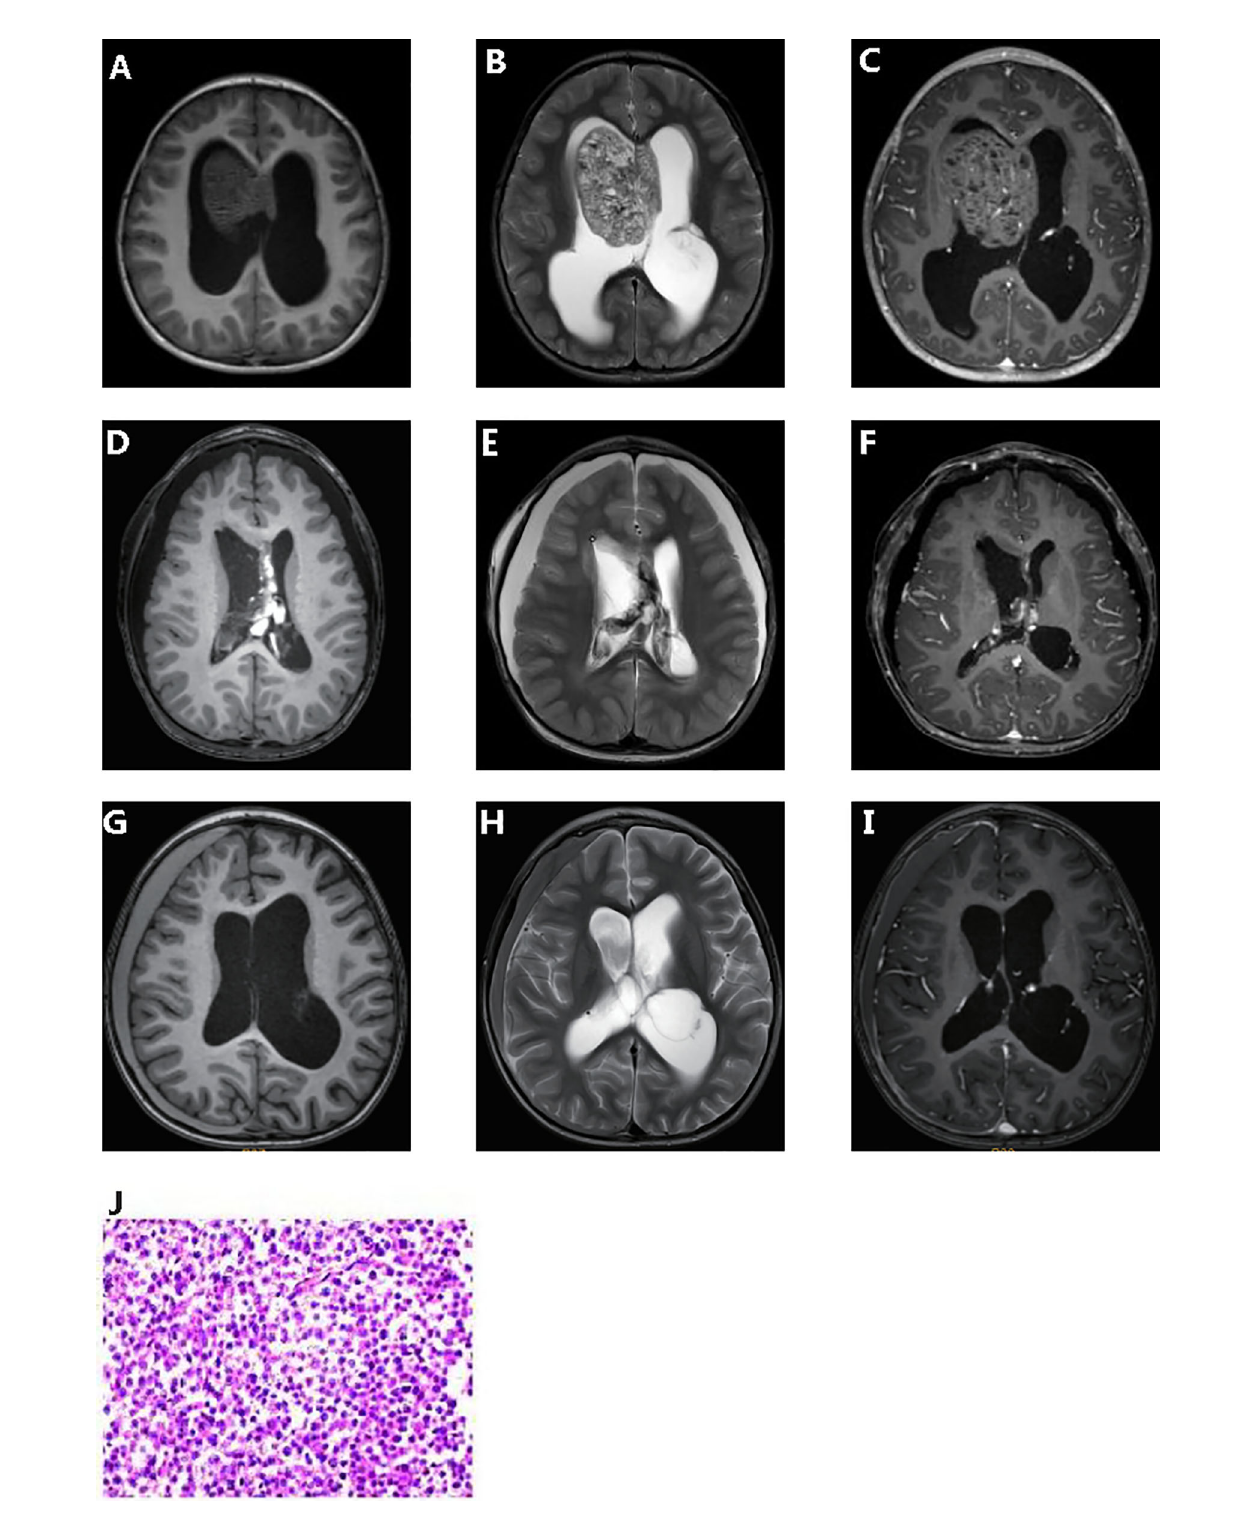
FIGURE 1 | Clinicopathologic features of patient. Pre-operative T1-weighted (A) and T2- weighted (B) dynamic contrast enhanced MRI (C) . Post-operative T1-weighted (D) and T2- weighted (E) dynamic contrast enhanced MRI (F) . 5 months post-operative T1-weighted (G) and T2- weighted (H) dynamic contrast enhanced MRI (I) . Hematoxylin and eosin (J)